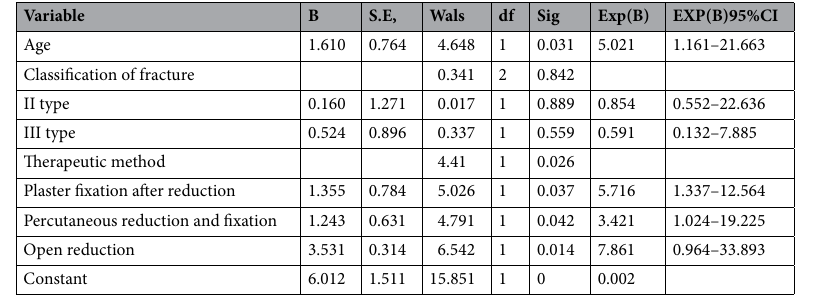
Table 3. Risk factors of poor prognosis in children with radial neck fracture by logistics regression